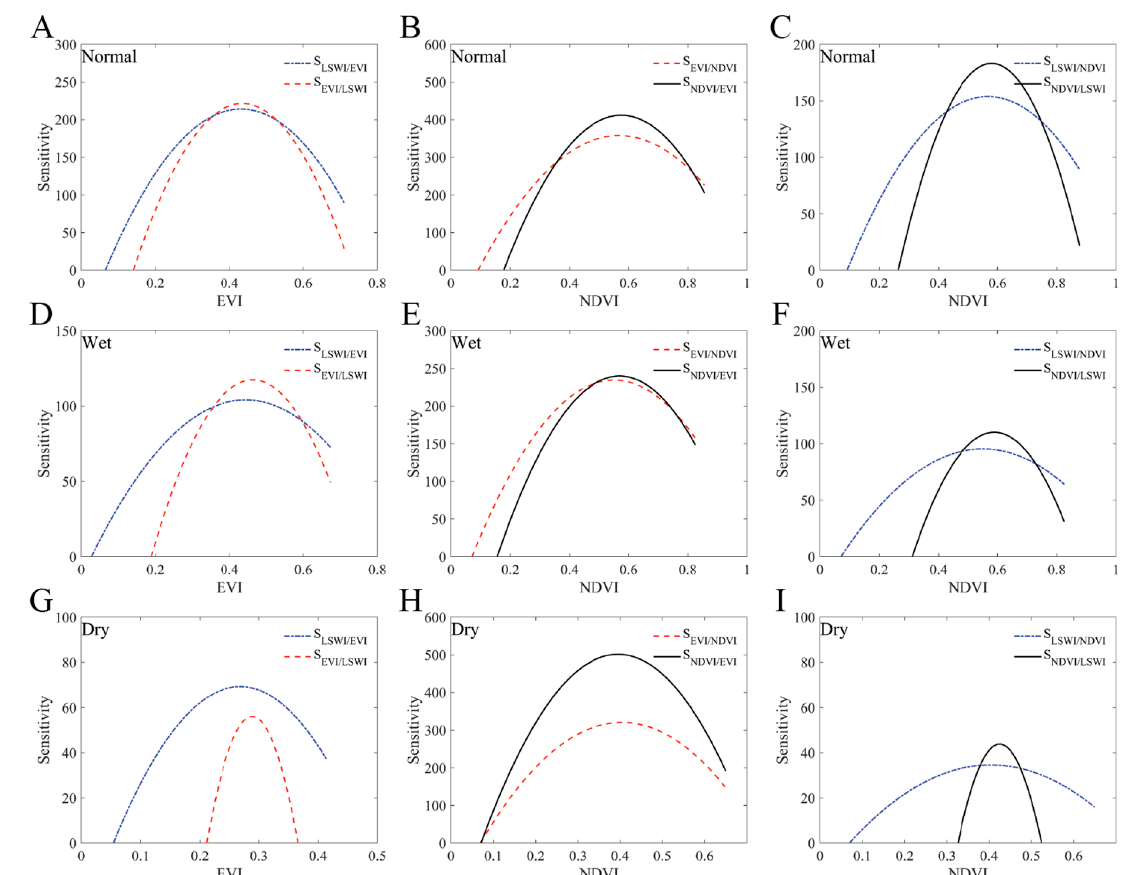
Figure 5. Unique comparisons of sensitivities between vegetation indices amongst differing climatic conditions (normal, wet, and dry). NDVI: normalized difference vegetation index; EVI: enhanced vegetation index; and LSWI: land surface water index. ( A ) Sensitivities comparison between EVI and LSWI during a normal year; ( B ) sensitivities comparison between EVI and NDVI during a normal year; ( C ) sensitivities comparison between NDVI and LSWI during a normal year; ( D ) sensitivities comparison between EVI and LSWI during a wet year; ( E ) sensitivities comparison between EVI and NDVI during a wet year; ( F ) sensitivities comparison between NDVI and LSWI during a wet year; ( G ) sensitivities comparison between EVI and LSWI during a dry year; ( H ) sensitivities comparison between EVI and NDVI during a dry year; ( I ) sensitivities comparison between NDVI and LSWI during a dry year.